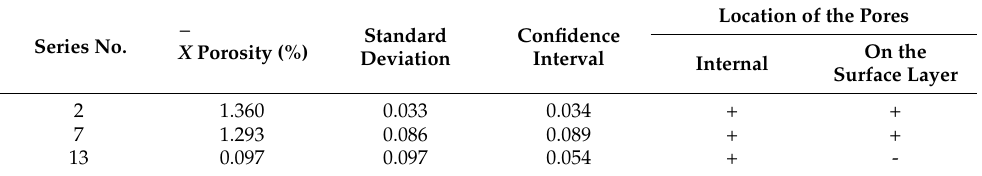
Confidence interval for population mean Student’s T distribution